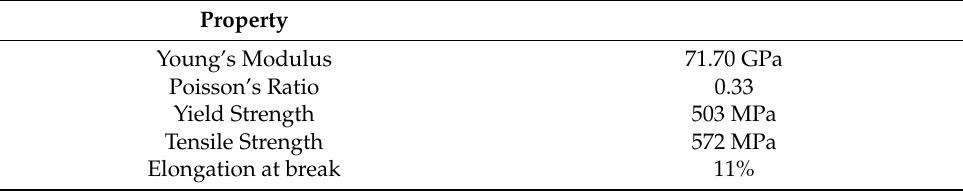
Table 3. Mechanical properties of the aluminum alloy 7075 T6.